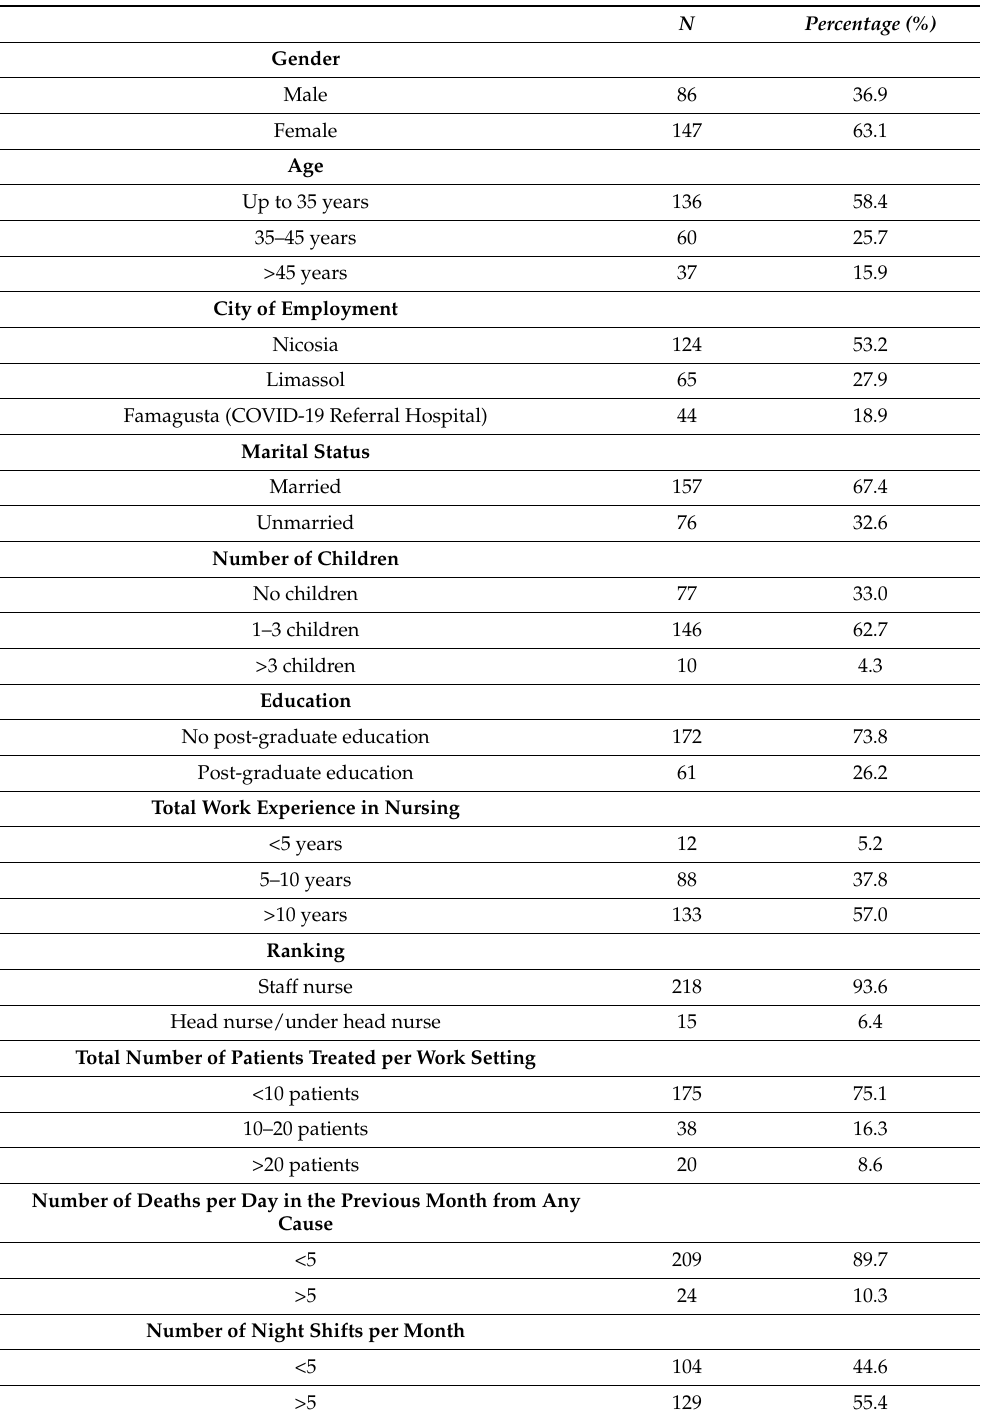
Table 1. The sociodemographic and employment characteristics of the sample (N =